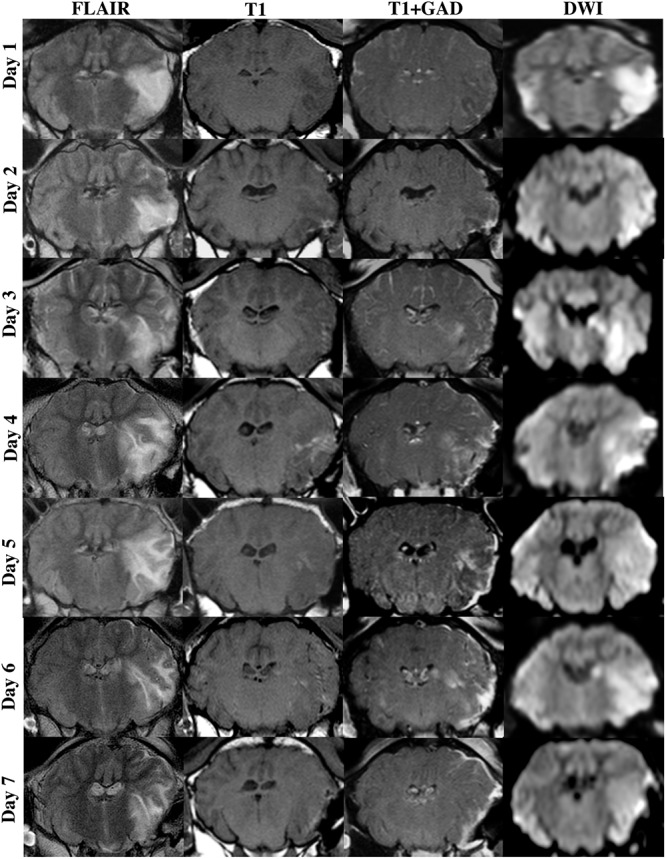
MRI findings following transient MCAO. Cerebral edema, as shown in coronal FLAIR MRI images, evolved from 1–6 days following stroke, beginning to resolve by 7 days. This evolution in cerebral edema was associated with enhanced extravasation of GAD across the BBB as seen on T1 weighted post-contrast series (T1+GAD) when compared to pre-contrast T1 series. Lesion volume, as shown in DWI MRI images, was comparable across time-points following stroke.